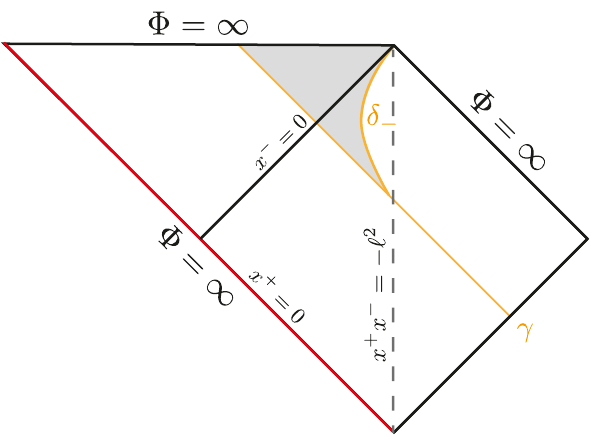
Figure 4 . Part of the Penrose diagram covered by x ± coordinates in the non-equilibrium state (2.25) with t + = 0 . The red line indicates the stress tensor singularity at x + = 0 . The region shaded gray is a trapped